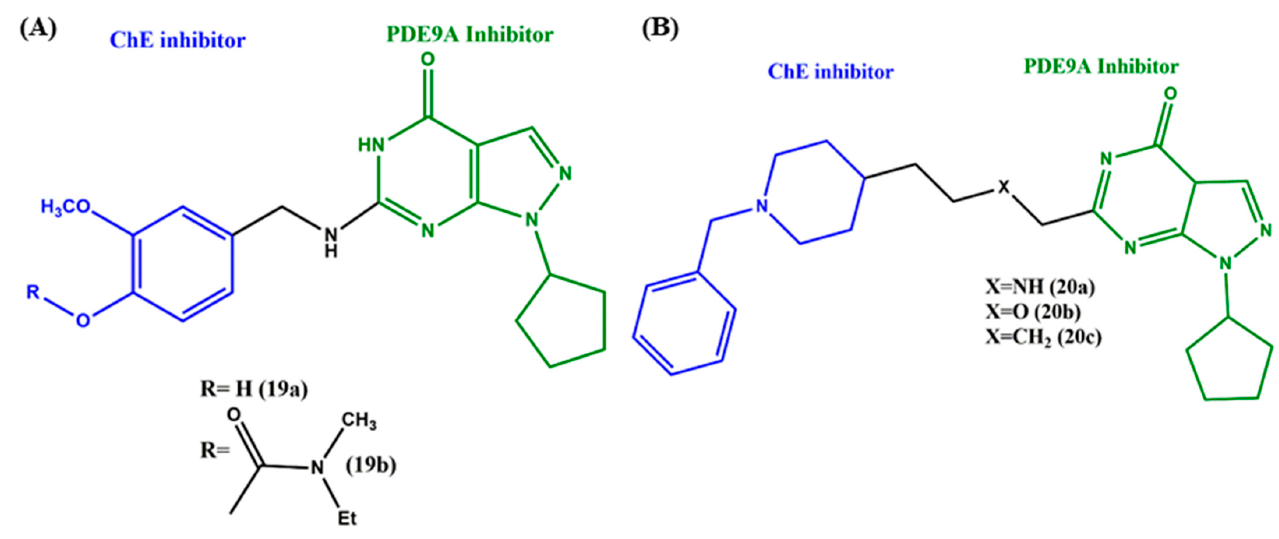
Figure 8. ( A ) and ( B ) Chemical structures of pyrazolopyrimidinone-derived